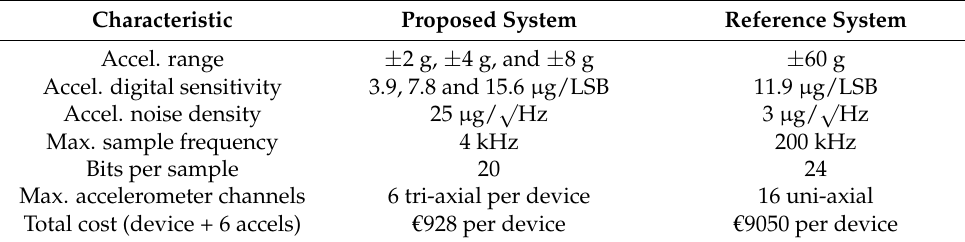
Table 1. Main characteristics of the proposed and reference